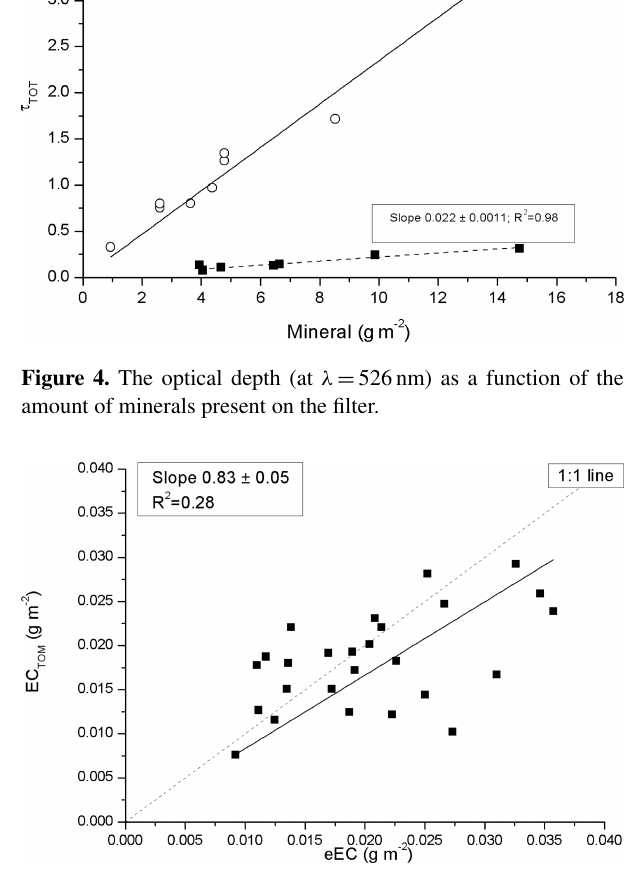
Figure 5. EC amount observed by the TOM (EC TOM ) for chimney soot and SiC mixtures as a function of estimated EC (eEC), using a PSAP optical depth signal before and after heating the filter and using the MAC eff , EC of 39.8m 2 g − 1 from Fig. 3.